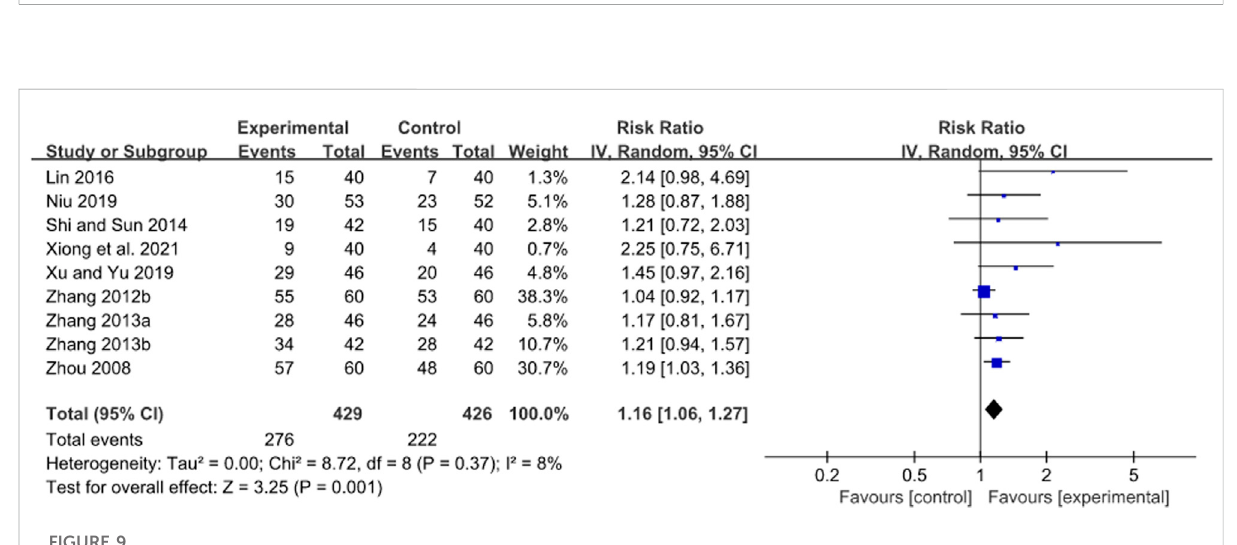
FIGURE 9 Forest plot of cure rate after JWC with the duration of 4